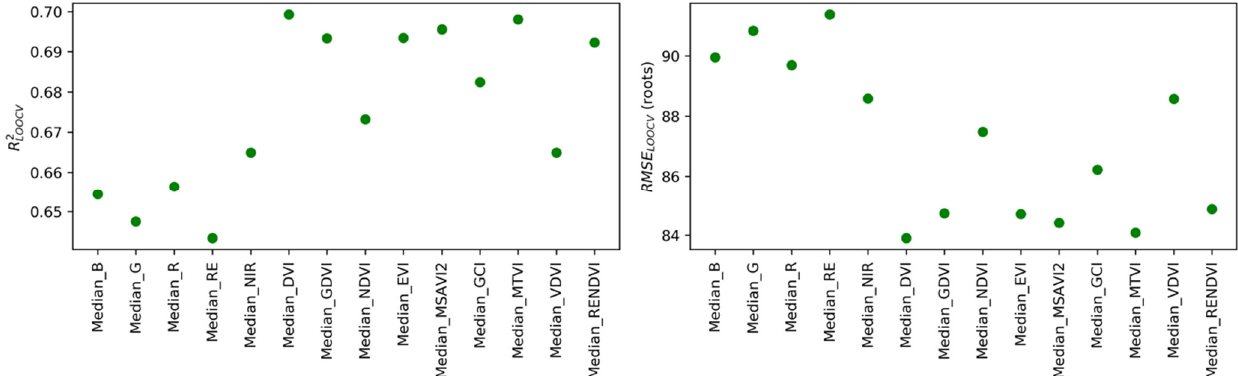
Figure 6. The area-augmented table beet root count R 2 ( left ) and RMSE ( right ) leave-one-out cross-validation performance (y-axis) for individual multiple linear regression models. Each model consists of one reflectance band or vegetation index shown on the x-axis combined with canopy area. The DVI paired with table beet canopy area was the best-performing model with R 2 = 0.70 and RMSE = 84